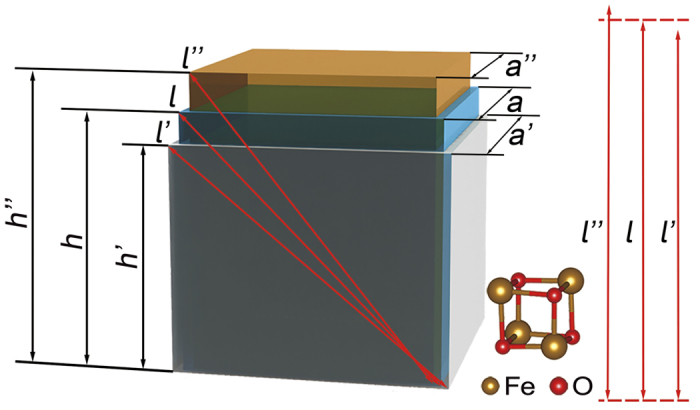
The sketch map shows the ideal model of deformation with equivalent volume.The FeB4O4 models without strain, with tensile or compressive strain are colored with blue, grey and orange, respectively. a, h and l each respects the in plane, out of plane direction Fe-O bond length and the Fe-Fe distance along face diagonal direction. The length of a′ and a″ is (1 + 6%)a and (1 − 6%)a, respectively. The ratio of a, a′ and a″ is correspondent with the calculation results. The local structure of FeB4O4 is also shown in the lower right corner.